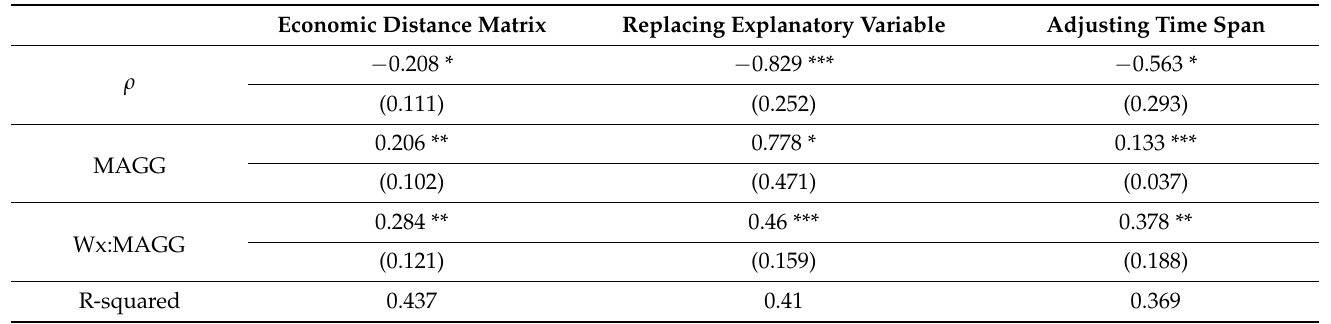
Table 8. Robustness test of the effect of MAGG on GIE.